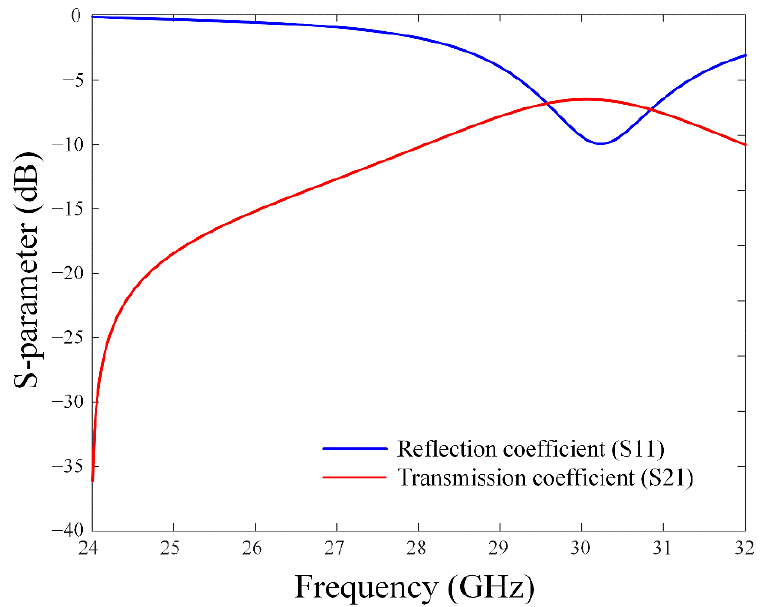
Figure 8. Reflection coefficient and transmission coefficient of the grid-slotted patch reflector.